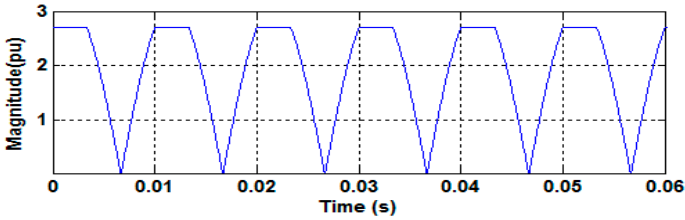
Figure 7. Generated reference waveform using 60-degree PWM.